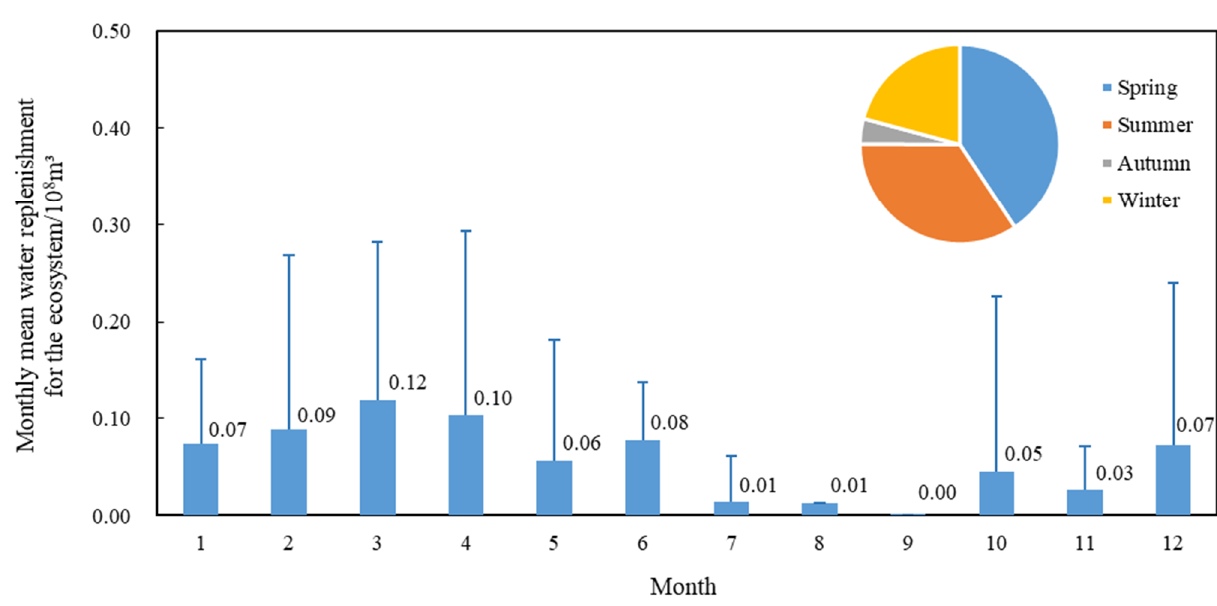
Figure 11. Monthly mean distribution corresponding to 38 years of water replenishment for the ecosystem in Baiyangdian Lake from 1980 to 2017 [35–39].